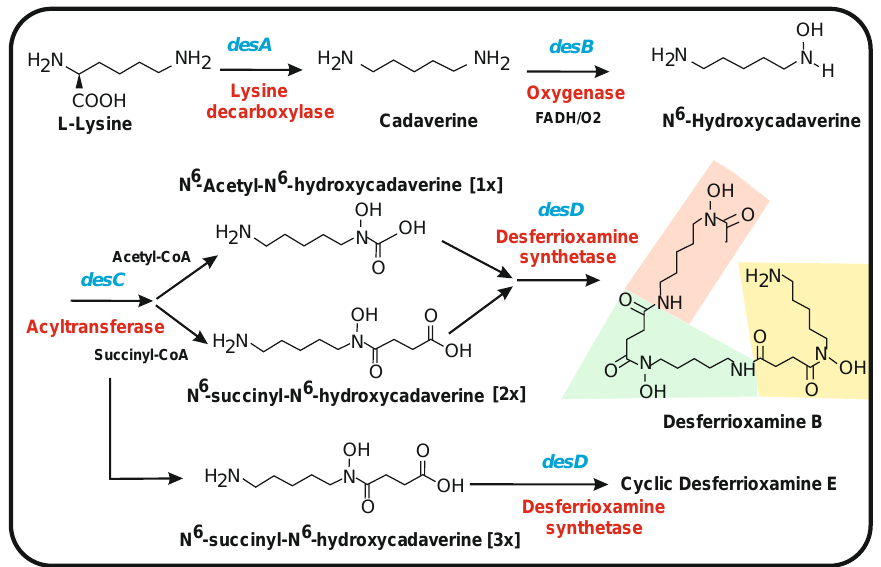
Figure 5. Biosynthetic pathway of desferrioxamines. The biosynthetic pathways of desferrioxamines B and E are shown. The enzymes responsible of every step are indicated in red letters. The encoding genes are shown in blue letters. The structure of the lineal desferrioxamine B is shown, indicating the position of the N 6 -acetyl-N 6 Hydroxycadaverine (pink) and of the two molecules of N 6 -succinyl-N 6 -Hydroxycadaverine (yellow and green colors).